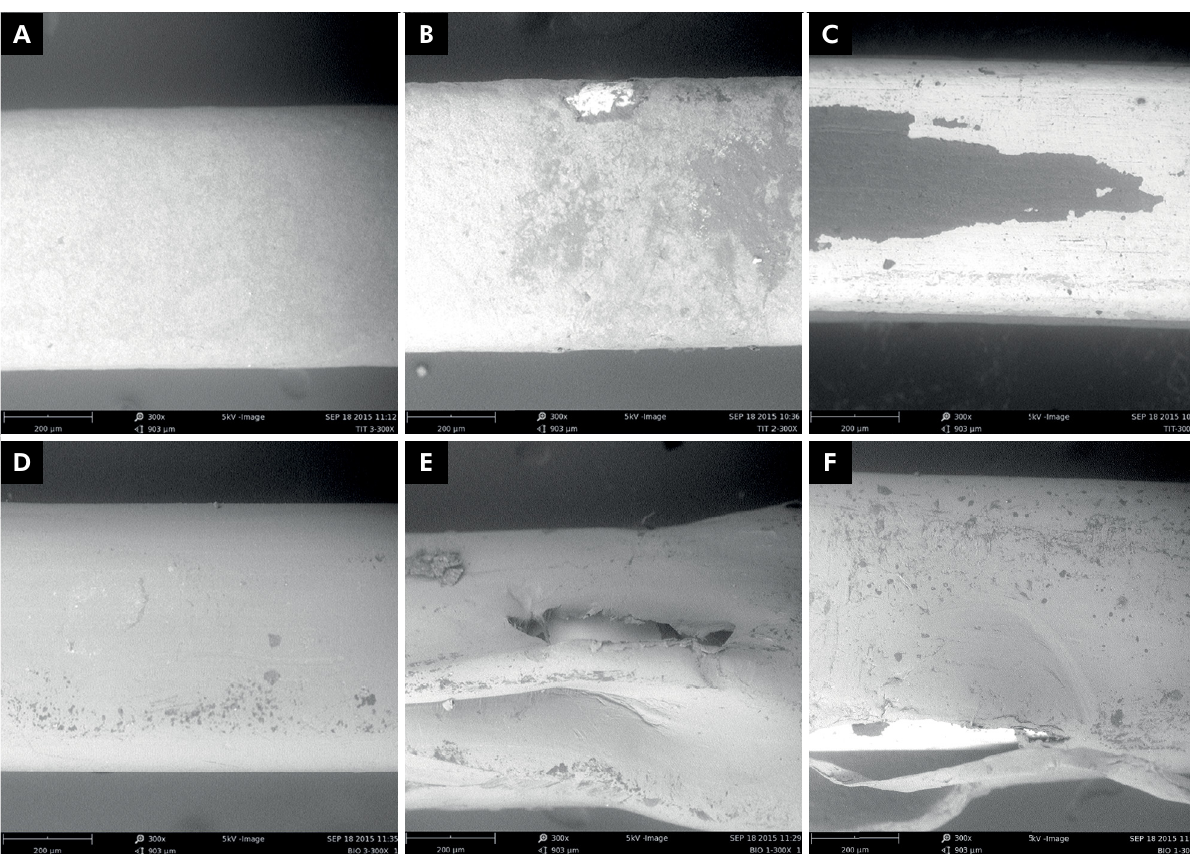
Figure 5. Photomicrographs of coated wires: A) as-received Titanol Cosmetic; B and C) postclinical Titanol Cosmetic; D) as-received Biocosmetic; E and F) postclinical Titanol Cosmetic. Original Magnification